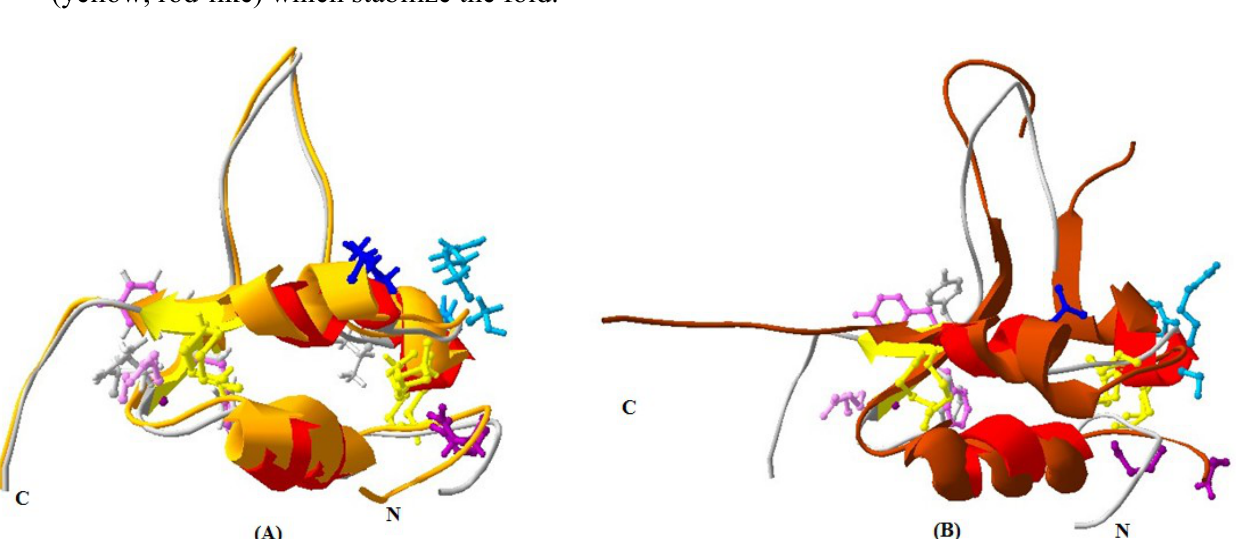
Figure 7. Superimposed 3D structure: Tianzhu white yak IGF2 (red) with human IGF2 (Ginger) ( A ) and human IGF1 (brown) ( B ). Binding sites were shown as rodlike molecules. The superimposition indicated very high similarity between the structures of yak IGF2 and the 3D structure of human IGF2. Binding sites were shown as rodlike molecules for yak IGFBP (modena), yak IGF-receptor and insulin-receptor and IGFBP (mauve) and yak IGF-receptor (blue); human IGFBP (modena), type 1 human IGF-receptor and insulin-receptor (white), type 2 human IGF receptor and IGFBP (grey), human IGF-receptor (blue). The view of IGF2 revealed three disulfide bonds (yellow, rod-like) which stabilize the